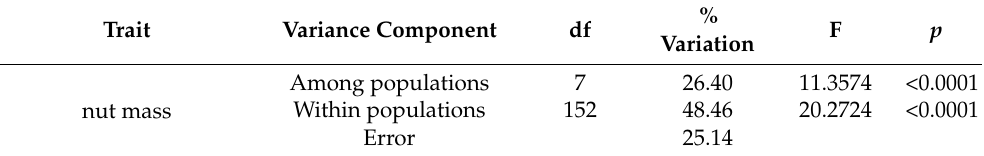
Table 3. Results of the hierarchical analysis of variance for nut and kernel morphometric